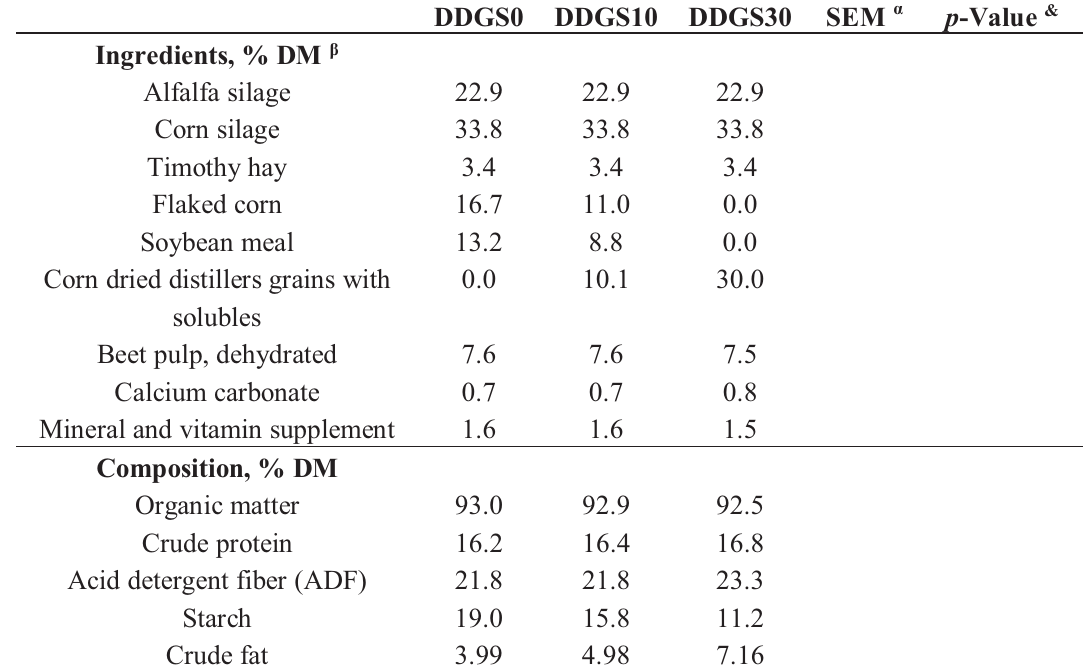
Table 1. Ingredients and composition of the three diets tested—0%, 10% and 30% dried distiller grains with solubles (DDGS0, DDGS10 and DDGS30)—and volume and composition of dairy slurry (kg·day (cid:2)1 ·cow (cid:2)1 ) as a function of feeding